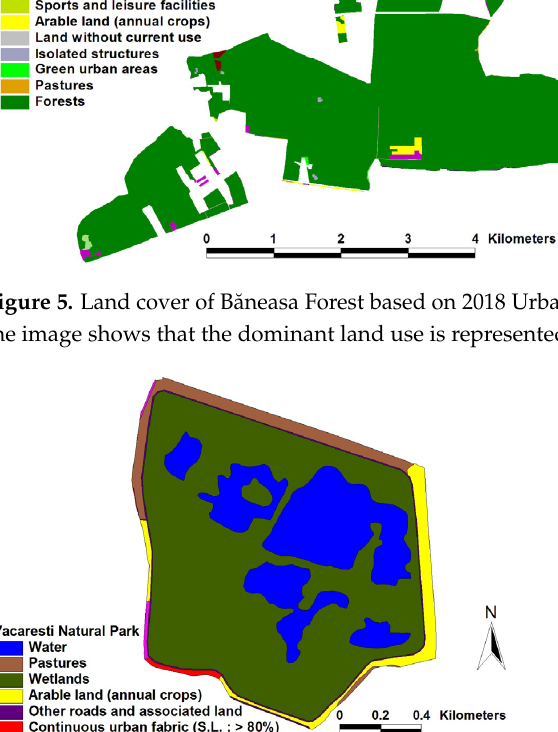
Figure 8. Land cover of Kabacki Forest, based on 2018 Urban Atlas data. As the name of site sug ‐ gests, the image shows that the dominant land use is represented by forests.